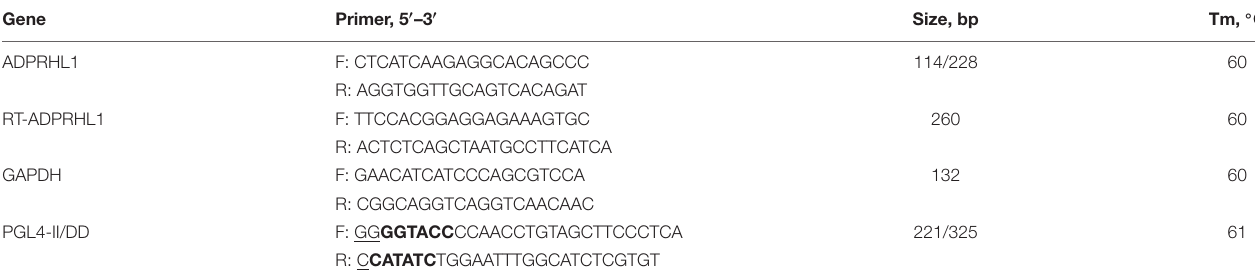
TABLE 1 | Primers used for PCR amplification of the chicken ADPRHL1 gene and mRNA transcripts. Gene Primer, 5 (cid:48) –3 (cid:48)